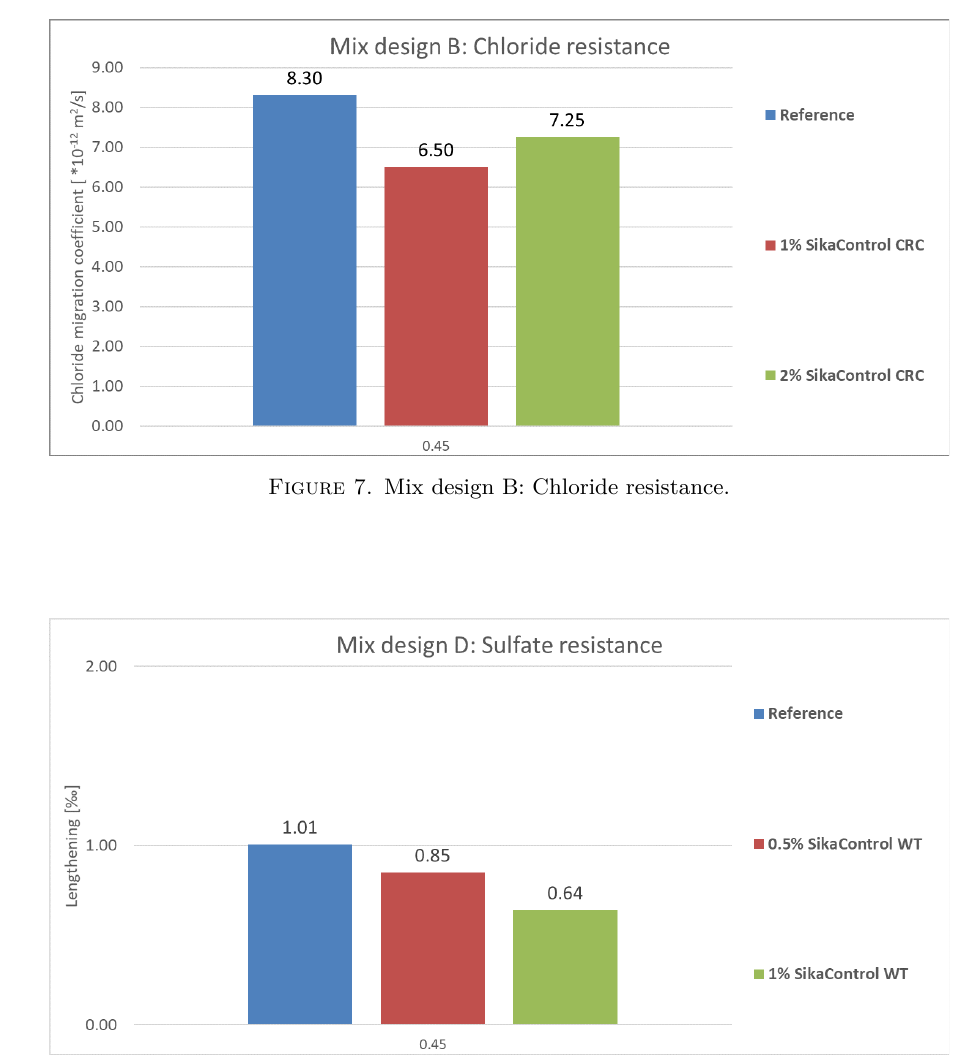
Figure 8. Mix design D: Sulfate resistance.